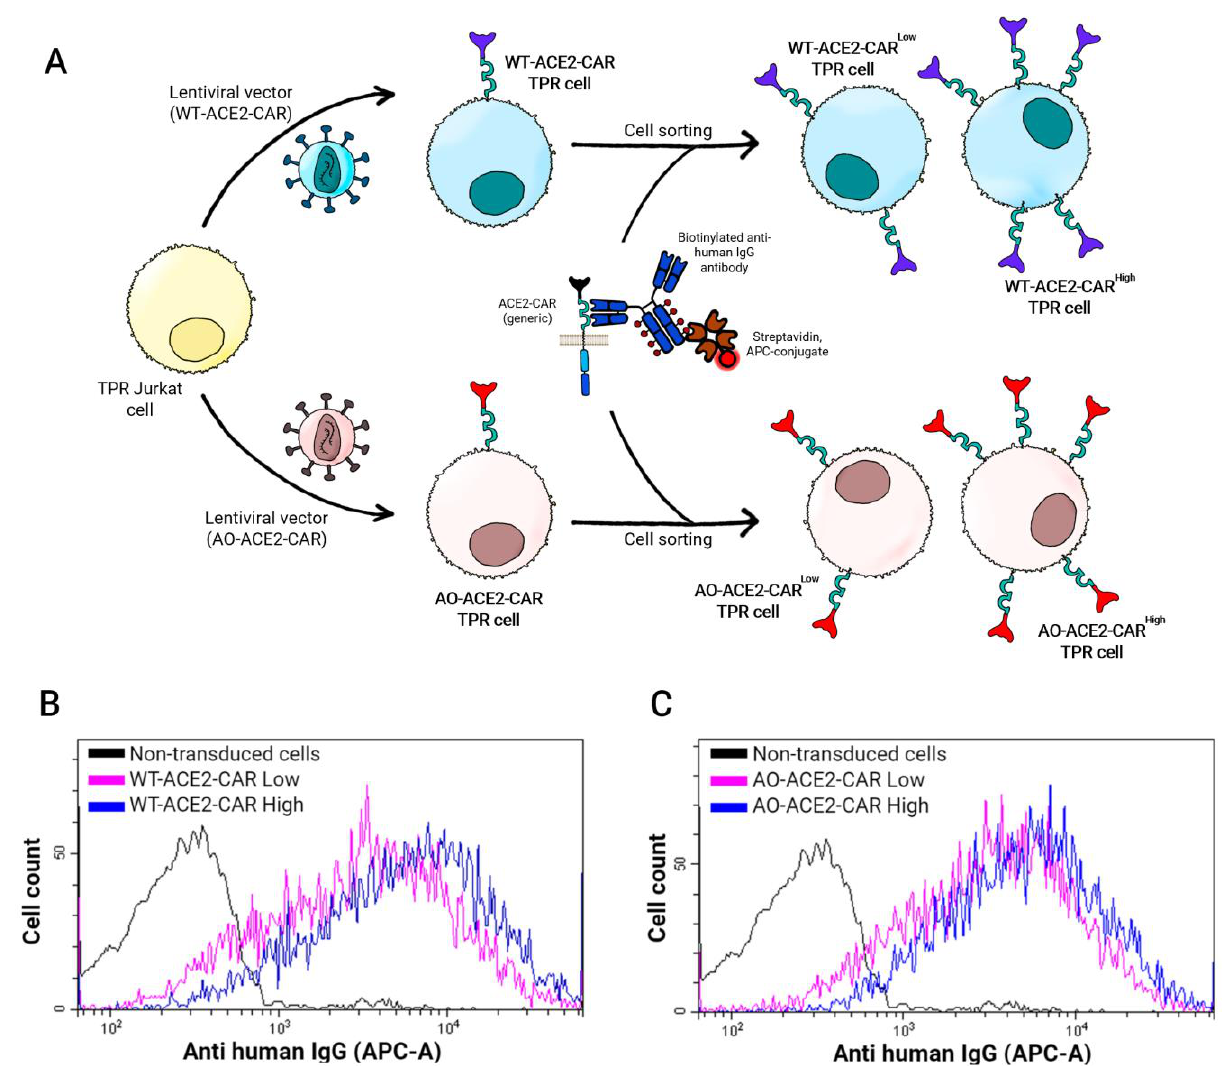
Figure 2. Establishment of ACE2-CAR-expressing Jurkat-TRP cell lines. ( A ) Schematic representa- tion of the sorting procedure: cells were sorted according to anti-IgG staining, recognizing the IgG-derived hinge domain of the ACE2-CAR molecules. The terms “Low” and “High” of the sorted WT ( B ) and AO ( C ) ACE2-CAR-TPR populations refer to lower and higher densities, respectively, of the protein expressed in the cell membrane.